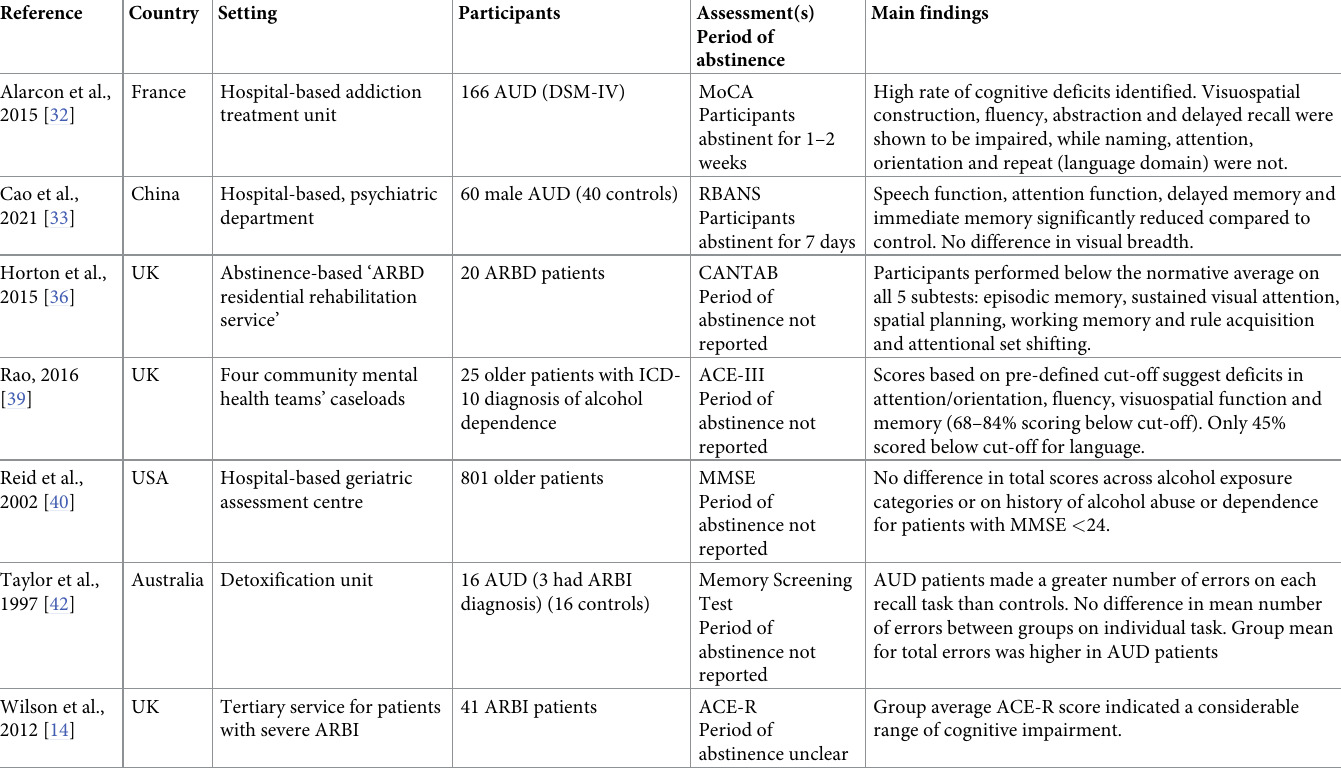
Table 5. Summary of studies: Descriptive reports of a cognitive assessment